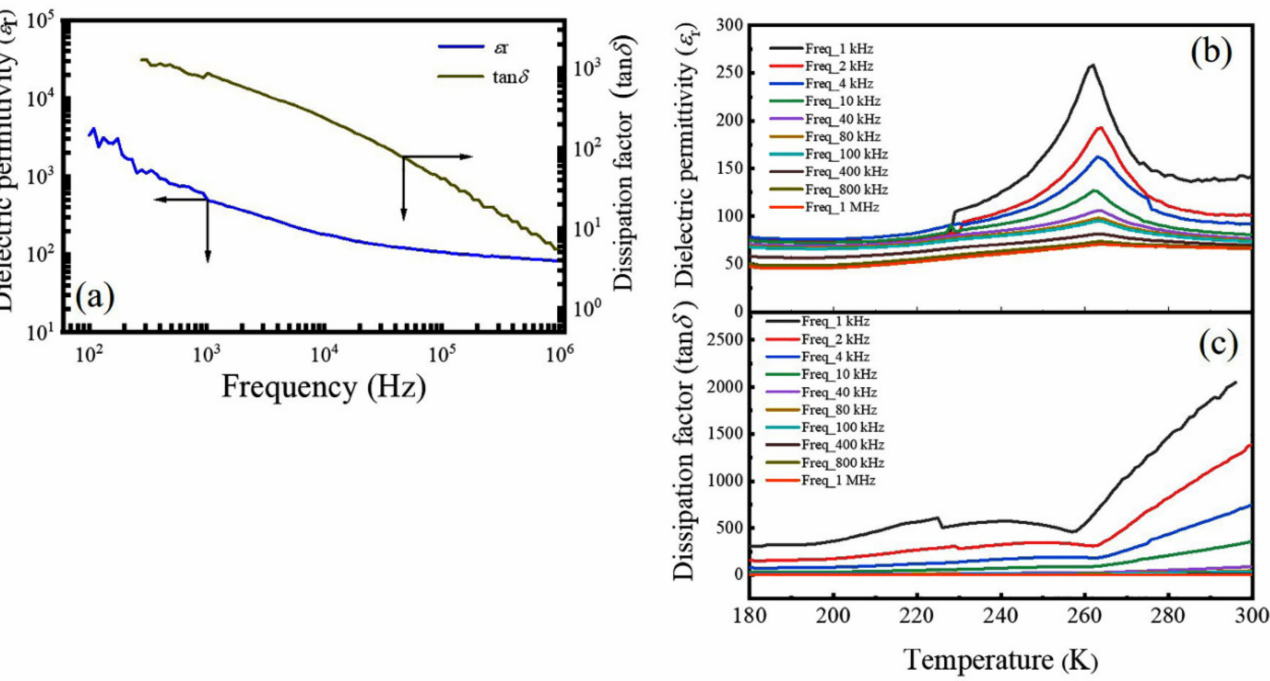
Figure 5. ( a ) Room temperature frequency dependence of the dielectric permittivity ( ε r ) and dissi- pation factor (tan δ ) of the LNMO ceramics prepared from NPs. ( b , c ) Corresponding temperature dependence of the dielectric permittivity and dissipation factor of the LNMO ceramics measured at different